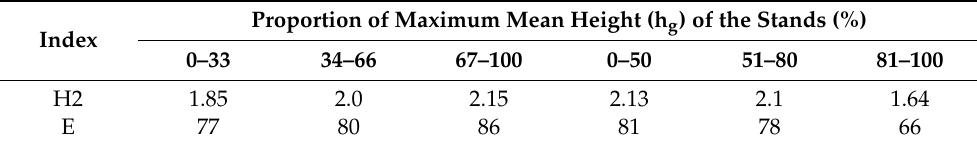
Table 4. Species diversity in the canopy layer at the management unit